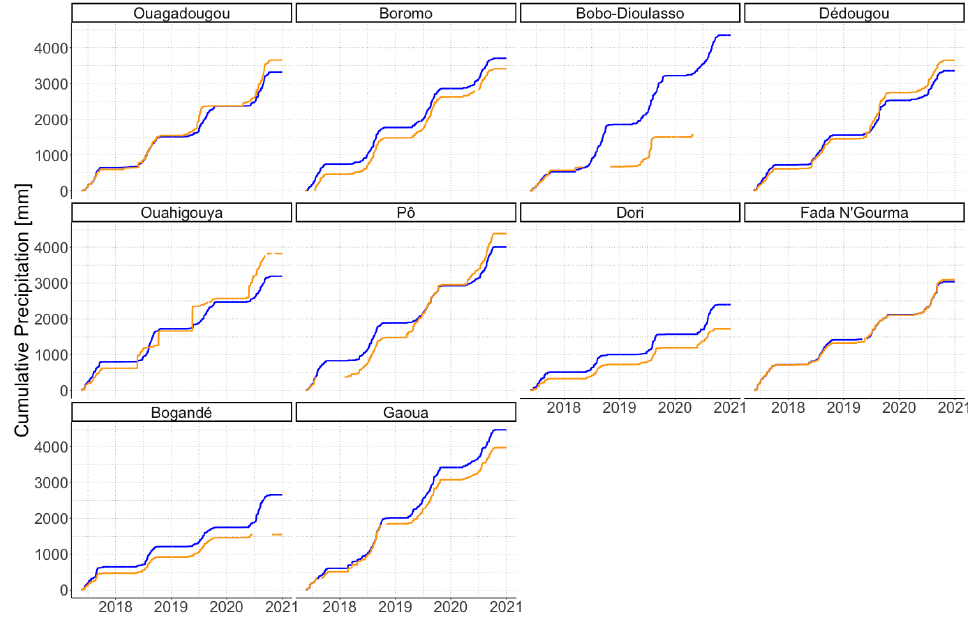
Figure 13. Comparison of cumulative precipitation between TAHMO stations in orange and the corresponding stations from the meteorological service of Burkina Faso in